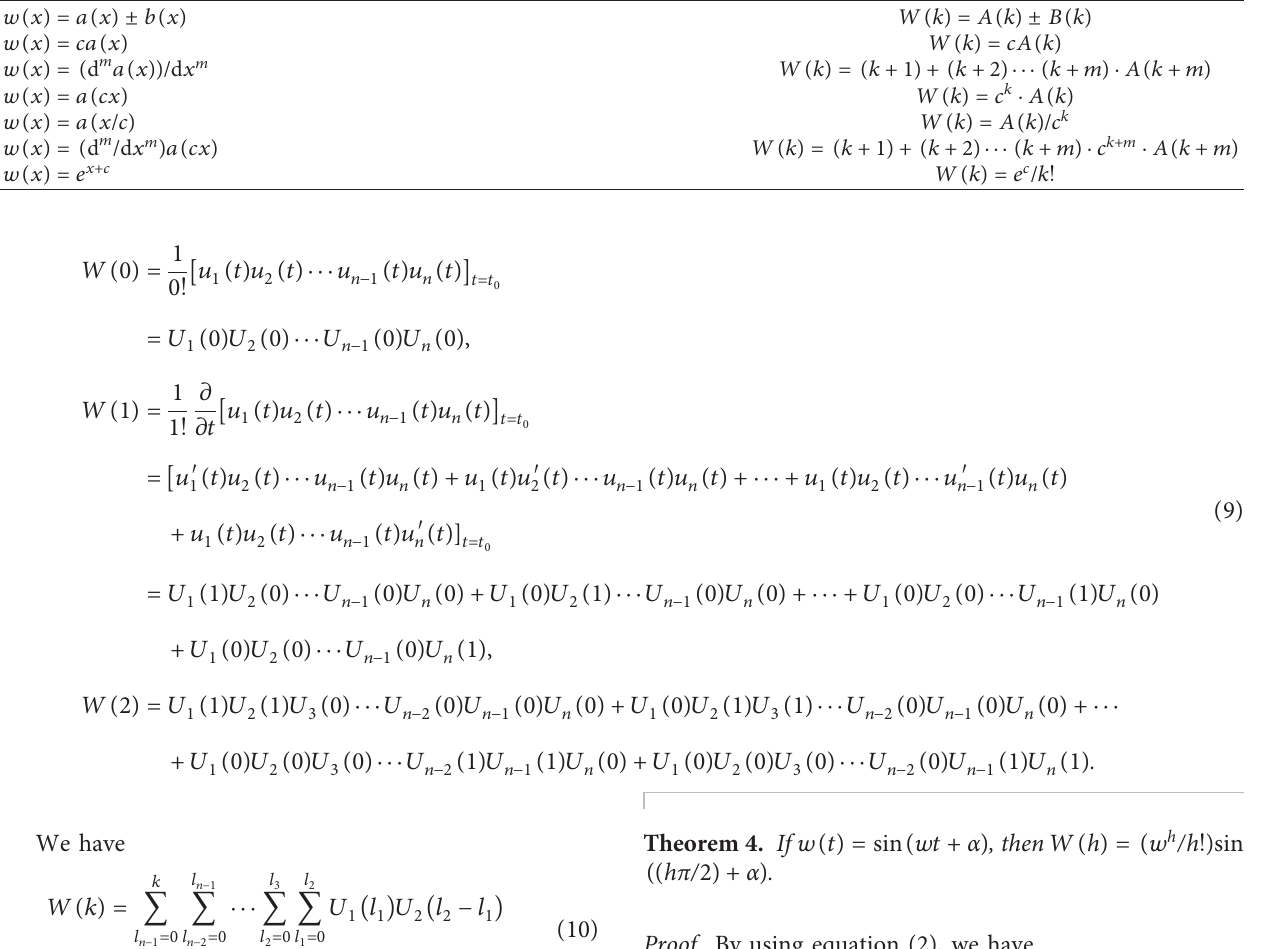
Table 1: The essential operations of the unique and transformed functions of the DT method. Unique